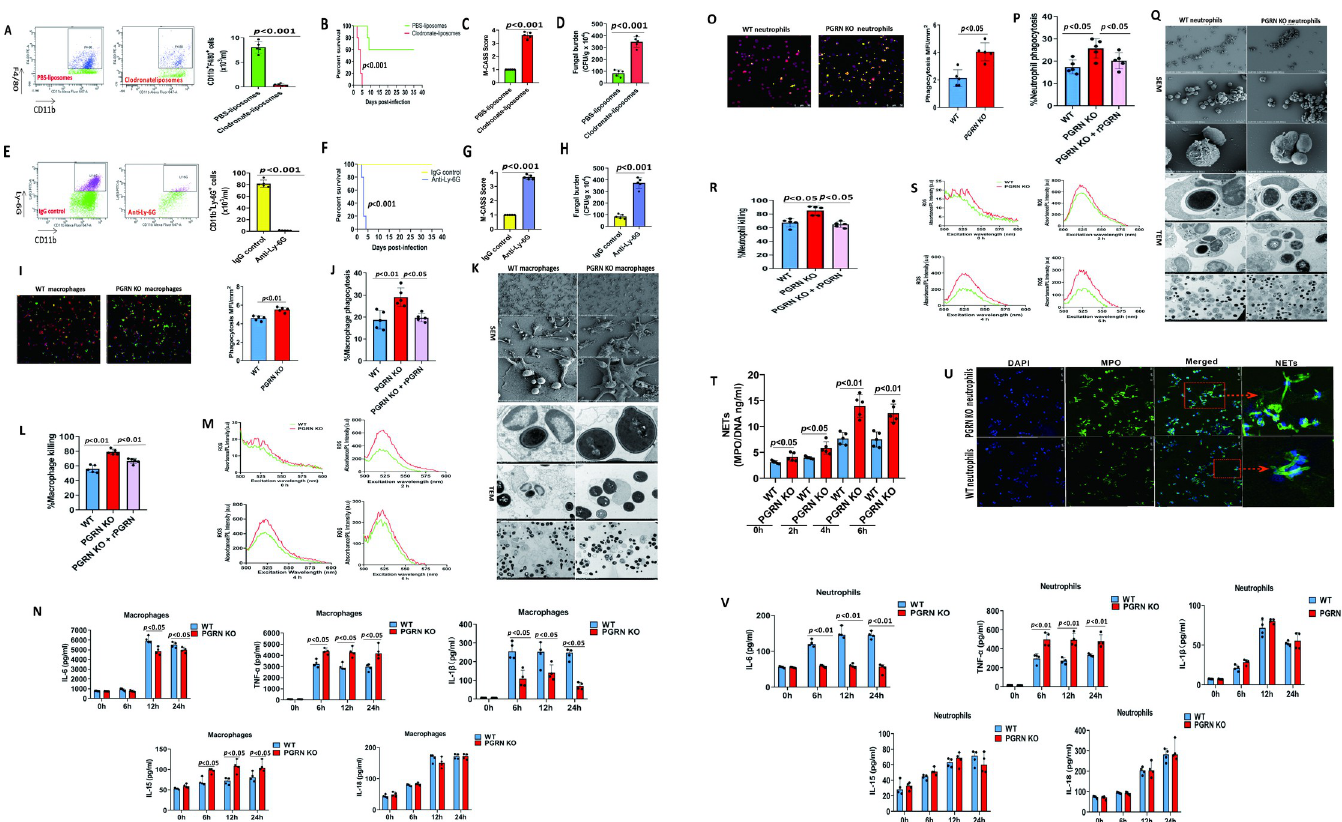
Fig 7. PGRN deletion increased phagocytosis and killing of macrophages and neutrophils in response to fungal infection. (A) The numbers of macrophages (CD11b + F4/80 + ) in the spleens were quantified by flow cytometry analysis in PGRN KO mice (n = 5) at 24 hours after clodronate-liposomes treatment. The Mann– Whitney U test was used to analyze the difference between groups denoted by horizontal lines. (B) Mortality after macrophage depletion by clodronate-liposomes and subsequent intravenous challenge with 4 x10 5 CFU of C . albicans in PGRN KO mice (n = 10). Kaplan-Meier survival curves were shown, and p value was determined by log-rank survival test. (C) Mouse Clinical Assessment Score for Sepsis (M-CASS) scores of PGRN KO mice (n = 5) with or without macrophage depletion at day 2 after intravenous infection with 4 × 10 5 CFU of C . albicans . The Mann–Whitney U test was used to analyze the difference between groups denoted by horizontal lines. (D) Fungal numbers in the kidneys of PGRN KO mice (n = 5) with or without macrophage depletion at day 2 after intravenous infection with 4 × 10 5 CFU of C . albicans . The Mann–Whitney U test was used to analyze the difference between groups denoted by horizontal lines. (E) The numbers of neutrophils (CD11b + Ly-6G + ) in the spleens were quantified by flow cytometry analysis in PGRN KO mice (n = 5) at 24 hours after anti-Ly-6G antibody treatment. The Mann–Whitney U test was used to analyze the difference between groups denoted by horizontal lines. (F) Mortality after neutrophil depletion by anti-Ly-6G antibody and subsequent intravenous challenge with 4 x10 5 CFU of C . albicans in PGRN KO mice (n = 10). Kaplan-Meier survival curves were shown, and p value was determined by log-rank survival test. (G) M-CASS scores of PGRN KO mice (n = 5) with or without neutrophil depletion at day 2 after intravenous infection with 4 × 10 5 CFU of C . albicans . (H) Fungal numbers in the kidneys from PGRN KO mice (n = 5) with or without neutrophil depletion at day 2 after intravenous infection with 4 × 10 5 CFU of C . albicans . The Mann–Whitney U test was used to analyze the difference between groups denoted by horizontal lines. (I) Rates of phagocytosis for FITC-labeled heat-killed C . albicans yeast at a multiplicity infection of 1:2 by WT (n = 5) and PGRN-deficient bone marrow-derived macrophages (BMDM, n = 5). Representative fluorescence images of heat-killed C . albicans yeast (as determined by overlay of green fungus) by WT and PGRN-deficient BMDM were shown. The Mann–Whitney U test was used to analyze the difference between groups denoted by horizontal lines. MFI = mean fluorescence intensity. (J) Rates of phagocytosis for live C . albicans yeast at a multiplicity infection of 1:2 by WT (n = 5) and PGRN-deficient BMDM (n = 5) preincubated with or without recombinant murine PGRN protein (100 ng/ml). The Mann–Whitney U test was used to analyze the difference between groups denoted by horizontal lines. (K) WT (n = 5) and PGRN-deficient BMDM (n = 5) were plated on bacteriologic plastic for transmission electron microscopy (TEM) or on coverslips for scanning electron microscopy (SEM) in the same well. BMDM were challenged with heat-killed C . albicans yeast (at a multiplicity of infection of 1:20) for 30 minutes at 37˚C. SEM showed that heat-killed C . albicans yeasts were no longer seen on the cell surface of PGRN-deficient BMDM, because they had been internalized by the cells (TEM data). In WT BMDM, many incomplete phagocytic cups were observed on the surface of BMDM, showing the arrest of the phagocytic cup closure. Moreover, TEM showed that few heat-killed C . albicans were internalized in WT BMDM compared with PGRN-deficient BMDM. (L) Percent killing of live C . albicans by WT (n = 5) and PGRN-deficient BMDM (n = 5) at a multiplicity infection of 1:10 in the presence or absence of recombinant murine PGRN protein (100 ng/ml). The Kruskal-Wallis test followed by Dunn’s multiple comparisons post test was used to analyze the difference between groups denoted by horizontal lines. (M) Reactive oxygen species (ROS) production by WT (n = 5) and PGRN-deficient BMDM (n = 5) stimulated with heat-killed C . albicans yeast (at a multiplicity of infection of 1:20). Representative examples were shown for the production of ROS. (N) Cytokine and chemokine levels in PGRN KO (n = 5) and WT (n = 5) BMDM at 24 hours after stimulation with heat-killed C . albicans yeast (at a multiplicity of infection of 1:20). The Mann–Whitney U test was used to analyze the difference between groups denoted by horizontal lines. (O) Rates of phagocytosis for FITC-labeled heat-killed C . albicans yeast at a multiplicity infection of 1:2 by WT (n = 5) and PGRN- deficient (n = 5) neutrophils. Representative fluorescence images of heat-killed C . albicans (as determined by overlay of yellow fungus) by WT and PGRN-deficient neutrophils were shown. The Mann–Whitney U test was used to analyze the difference between groups denoted by horizontal lines. MFI = mean fluorescence intensity.